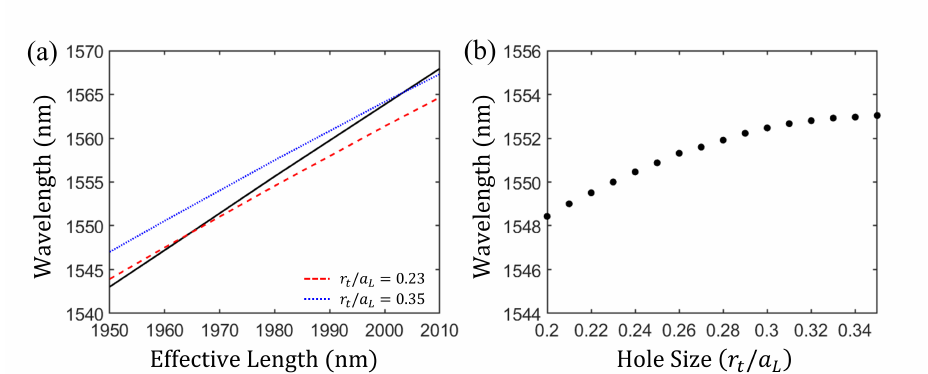
Figure 3. ( a ) Resonance wavelength plotted as a function of the effective length. The black solid line and blue dotted line ( r t / a L = 0.35) represent the resonance wavelength for the PMC boundary and the PC boundary vs. effective length, respectively. In this situation, the effective length of the resonator with the PMC-like boundary is equal to the resonator length of the resonator with the PMC boundary. The red dashed line represents the resonance wavelength for the PC with a tapering hole ( r t / a L = 0.23) vs. effective length. ( b ) Resonance wavelength shift caused by the change in the hole radius ( r t / a L ) of a tapering hole near the boundary of the PC for the effective length of 1967 nm. For the hole size r t / a L = 0.23, the resonance wavelength was approximately 1550 nm